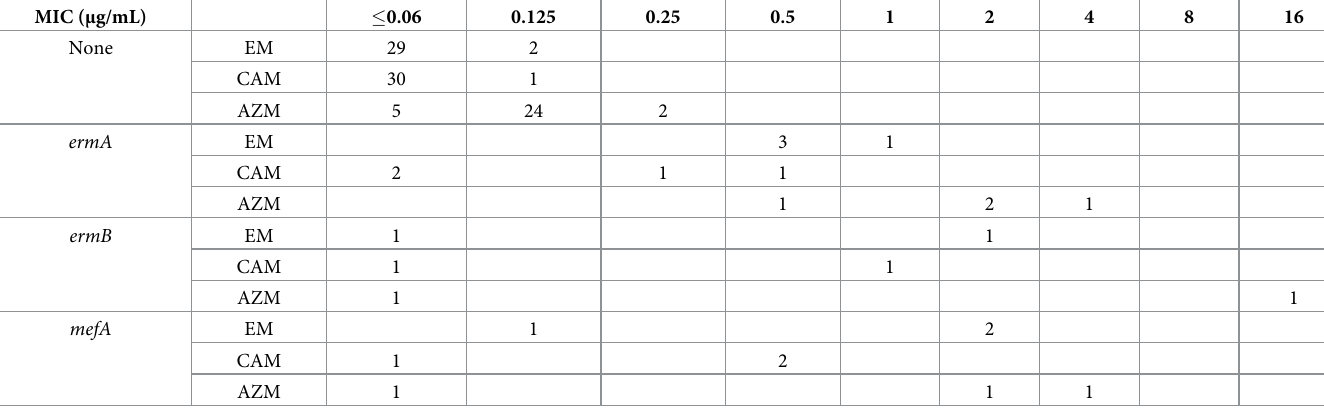
Table 5. Number of GBS isolates related between macrolide resistance genes and MIC.